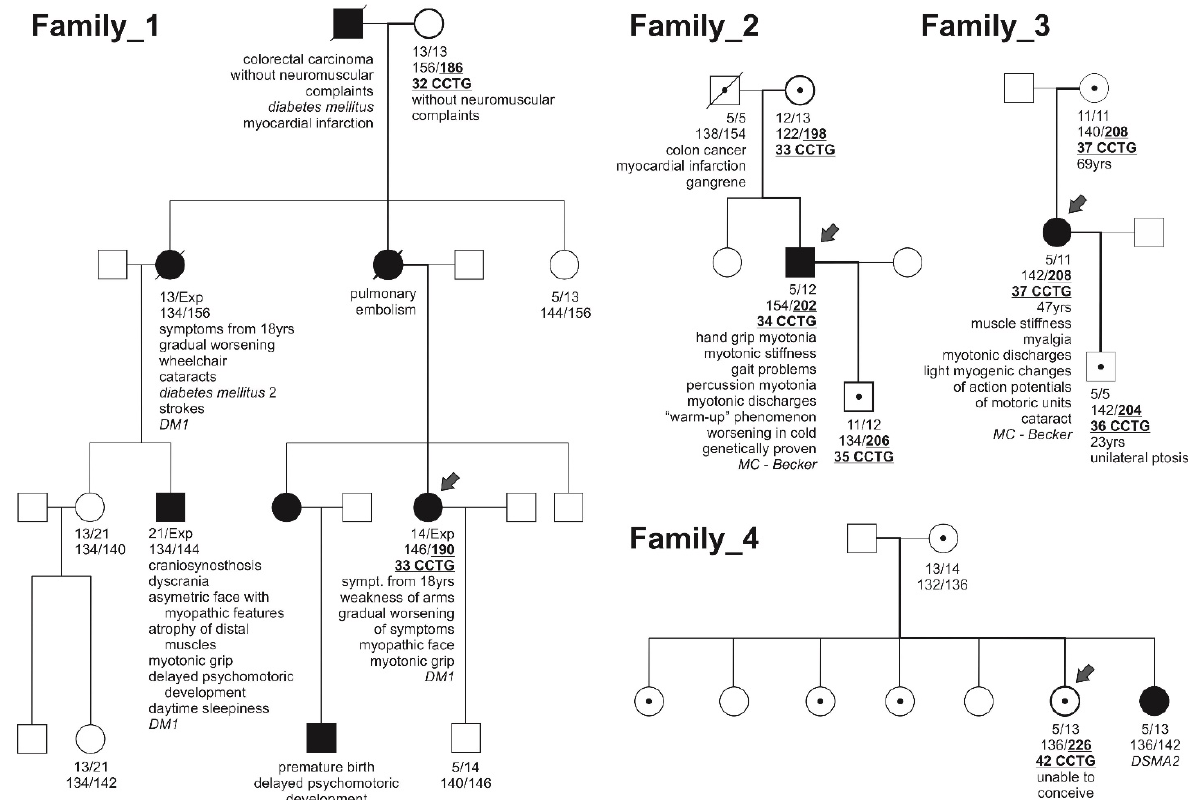
Figure 1. Genetic pedigree charts of the four described families. The first text line under each individual indicates the DM1 genotype and is shown in CTG repeat numbers, the second line indicates the DM2 genotype in base pairs for the complex repeat tract, while the third one shows the CCTG repeat numbers of the uninterrupted CNBP alleles. Individuals with no displayed numbers indicate no DNA samples available for analysis. Patients marked by dots are carriers of the identified pathogenic variants while the family members highlighted in black suffer from neuromuscular complaints: myotonic dystrophy (DM1) in family_1, autosomal recessive myotonia congenita in family_2 and 3 (MC–Becker) and autosomal recessive distal spinal muscular atrophy (DSMA2) in family_4. Arrows indicate individuals in whom the uninterrupted CCTG allele was initially identified (index patients), the bold and underlined numbers in the DM2 genotypes indicate the length of the uninterrupted alleles of interest and the bold connector lines show the inheritance line of these alleles through the generations.